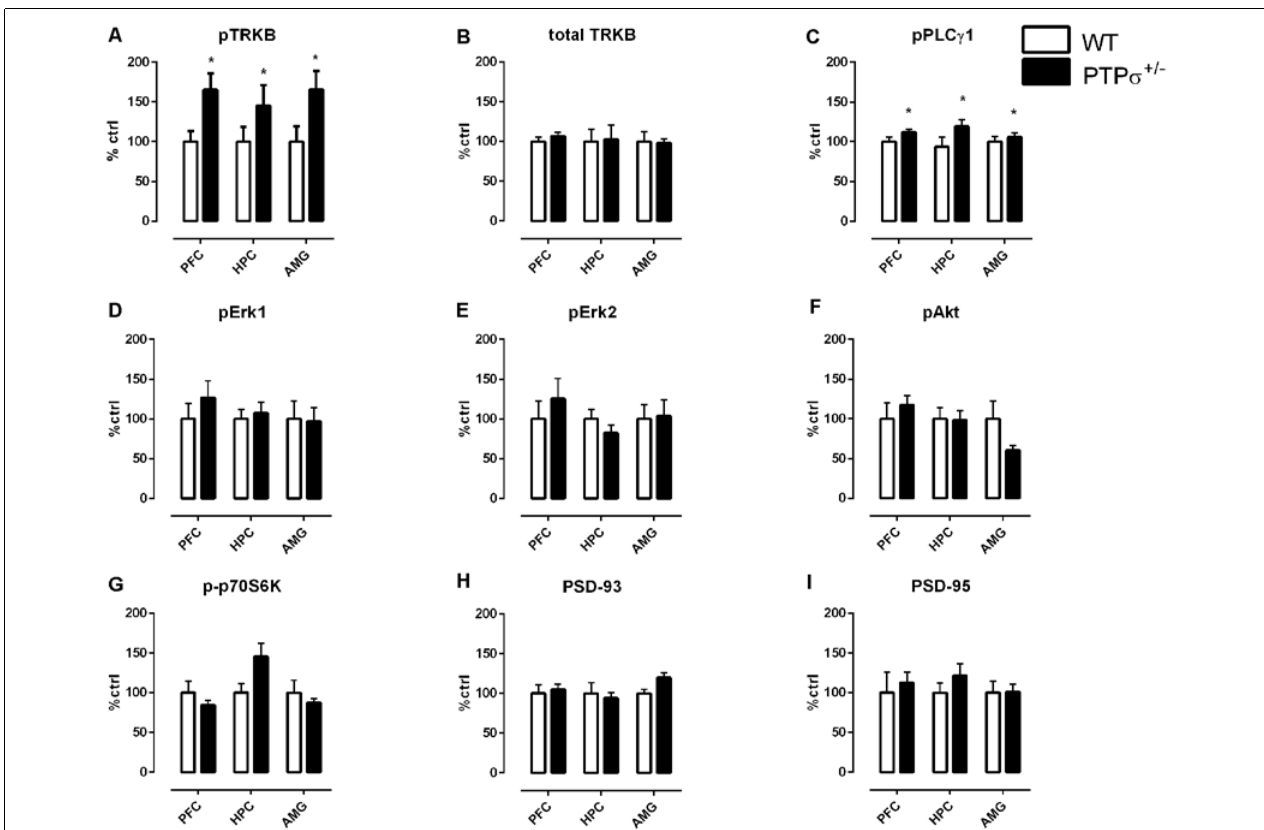
FIGURE 1 | Molecular profile of changes in plasticity-related proteins induced by PTP σ genetic deficiency in different brain areas. (A) PTP σ + / − mice have increased phosphorylation of TRKB receptors (pTRKB) and (B) no changes in total TRKB levels in the prefrontal cortex (PFC), hippocampus (HPC), and amygdala (AMG). PTP σ + / − mice display (C) increased phosphorylation of PLC γ 1 (pPLC γ 1), no changes in phosphorylation of (D,E) Erk, (F) Akt, (G) p70S6 kinase and no changes in total levels of (H) PSD-93 and (I) PSD-95 expression. Data on (A) was measured by ELISA and on (B–I) by Western blot. Data were analyzed by two-way ANOVA * p <